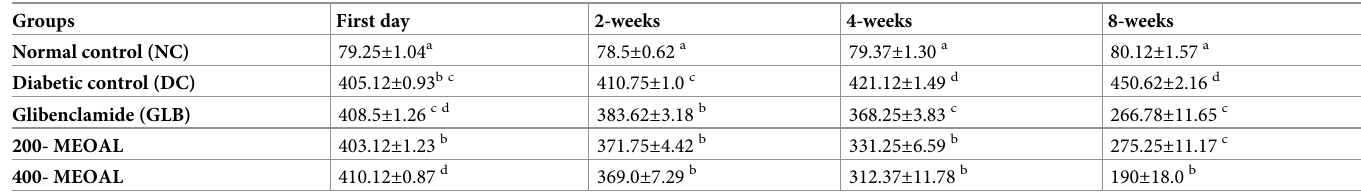
Table 5. Effects of GLB or MEOAL on the blood glucose of STZ-induced diabetic rats at different interval periods in different groups.